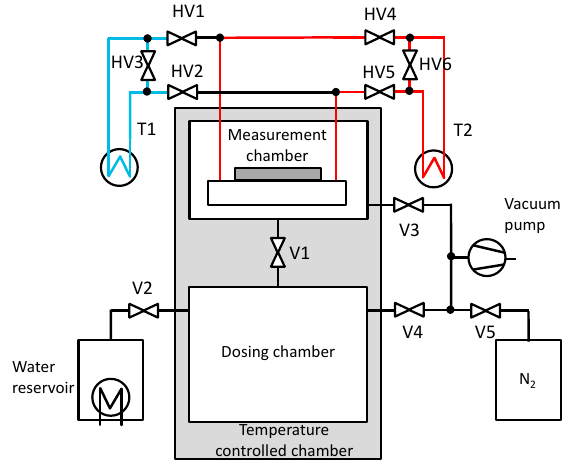
Figure 3. Kinetic measurement setup. V, valve; T, thermostat; HV, hydraulic valve.